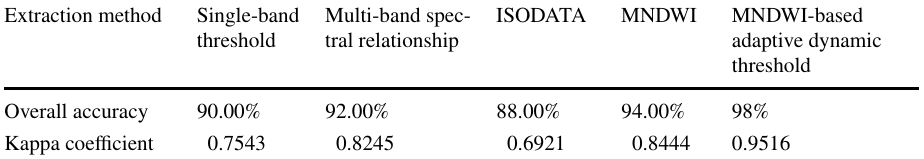
Table 5 Overall accuracy and kappa coefficient of the five